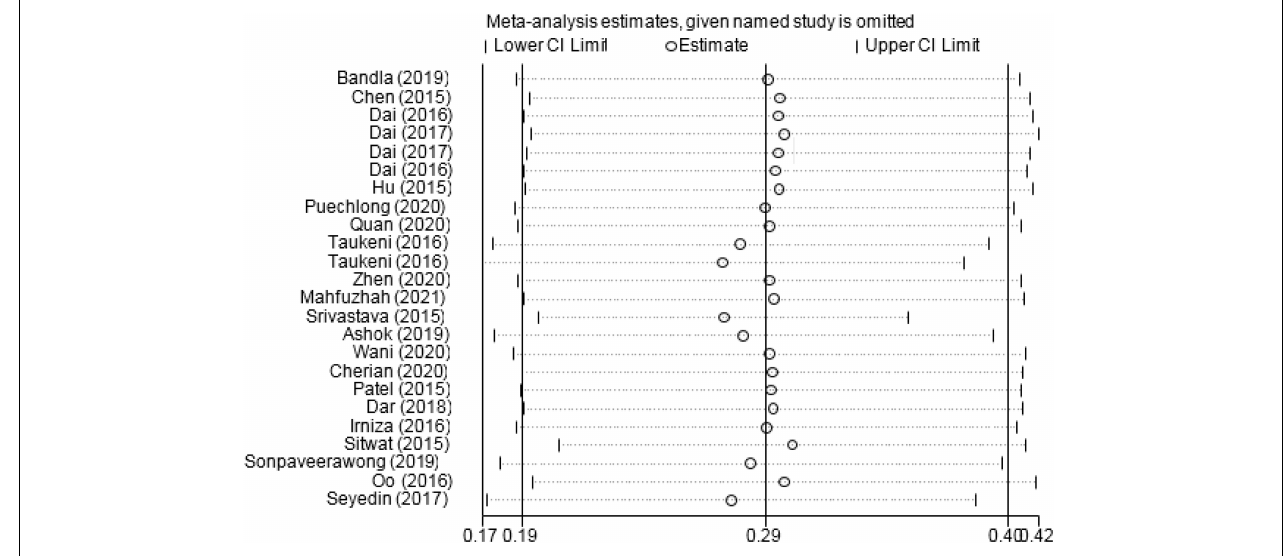
FIGURE 3 | Sensitivity analysis for the prevalence of